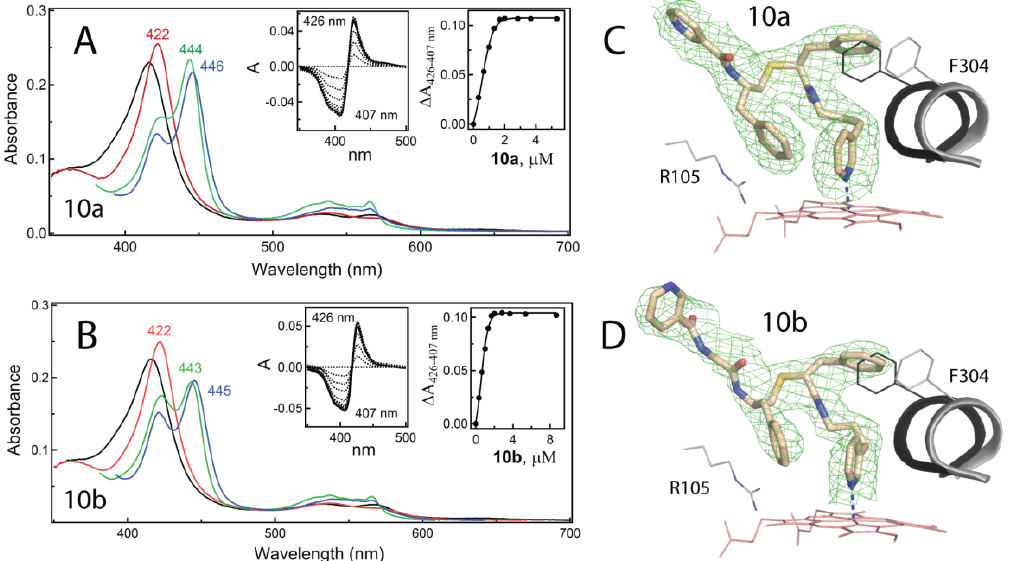
Figure 7. Spectral properties ( A , B ) and the binding modes of 10a , b ( C , D ). ( A , B ) Ligand-induced spectral changes in CYP3A4. Absorbance spectra of ferric ligand-free and inhibitor-bound CYP3A4 are in black and red, respectively. Spectra of ferrous ligand-bound CYP3A4 and its CO-adduct are in green and blue, respectively. Left insets are the difference spectra recorded during equilibrium titrations; the right insets are titration plots with quadratic fittings. The derived K s values are listed in Table 1. ( C , D ) Binding modes of 10a – b observed in the crystal structures. The central part of the I-helix and Phe304 in the inhibitory complexes and water-bound CYP3A4 (5VCC structure) are depicted in gray and black, respectively. Polder omit electron density maps contoured at 3 σ level are shown as green mesh. The 10a - and 10b -bound structures of CYP3A4 have the PDB ID codes 7UFE and 7UFF,